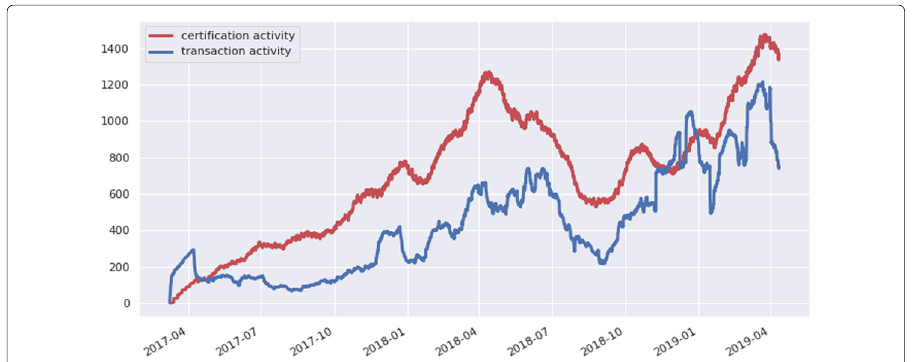
Fig. 4 30 days rolling sum of the activities (see Definition 5) of the certification stream C (red curve) and the transaction stream between members T MM (blue